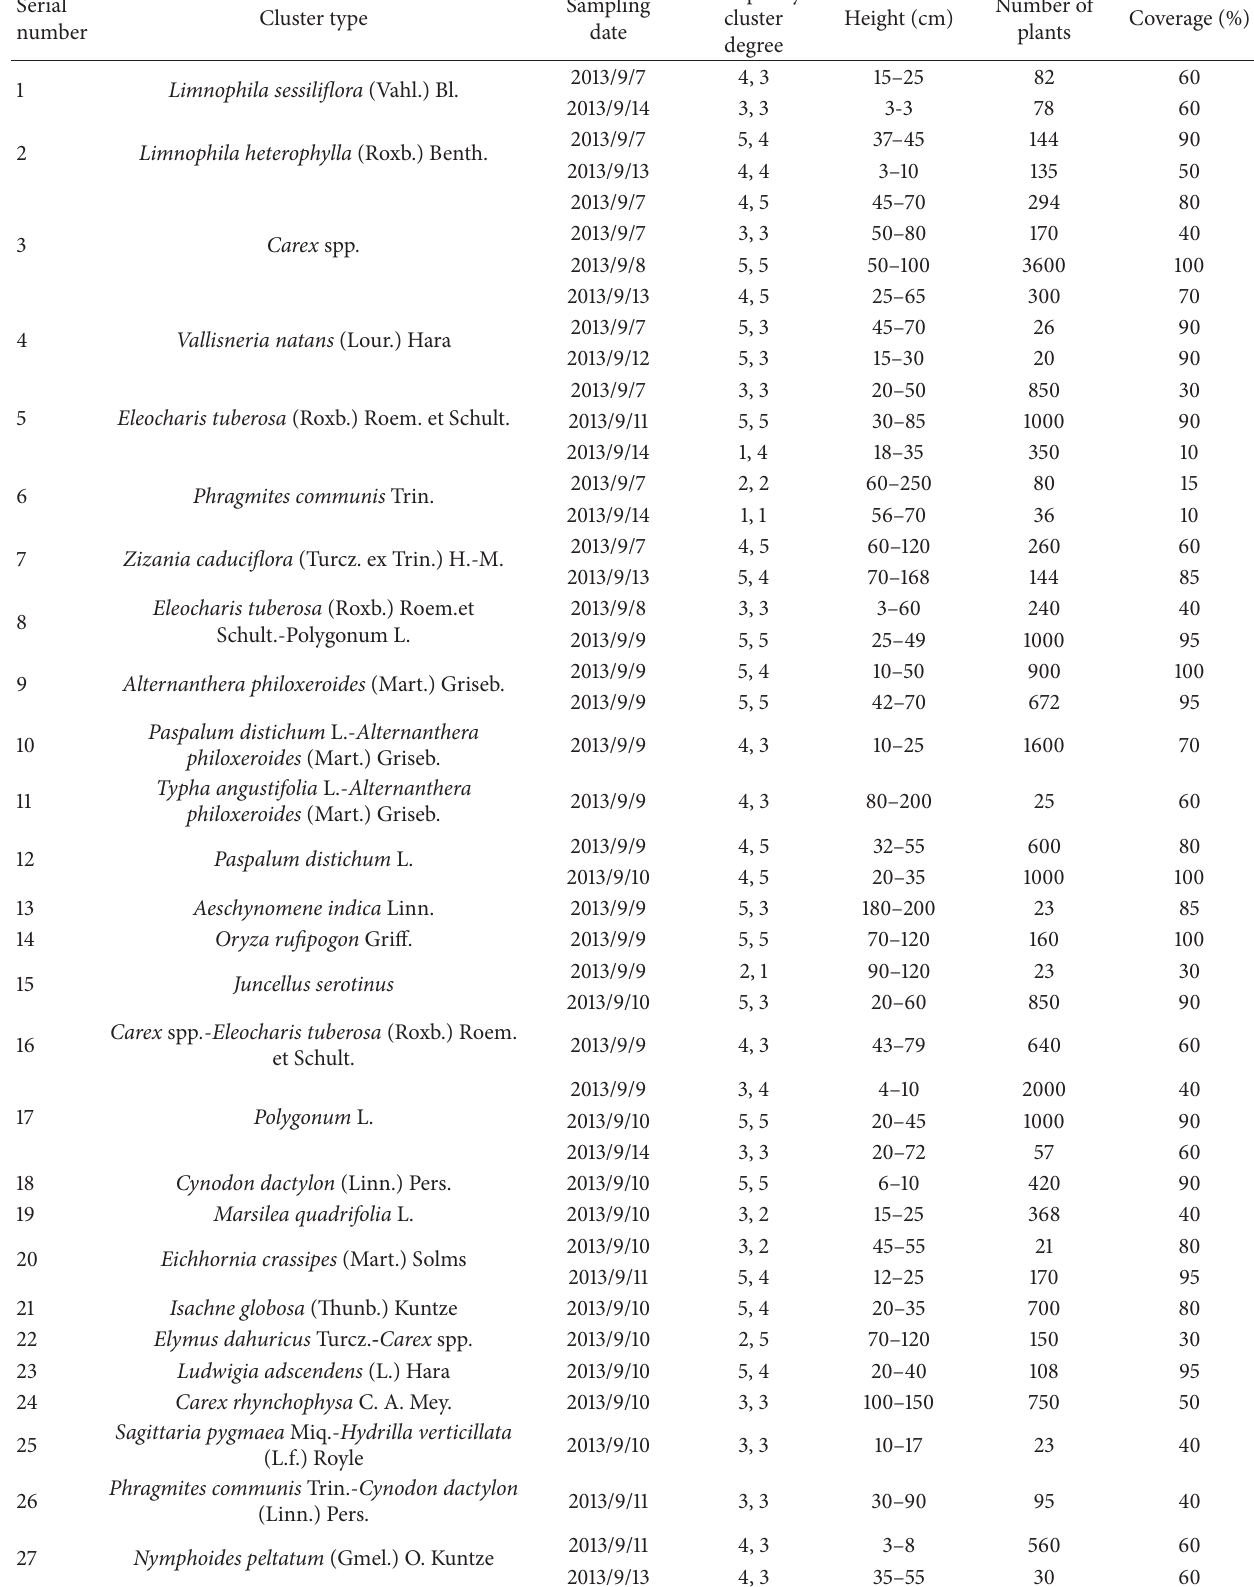
Table 3: The habitat profiles of main association types in macrophyte communities in the Poyang